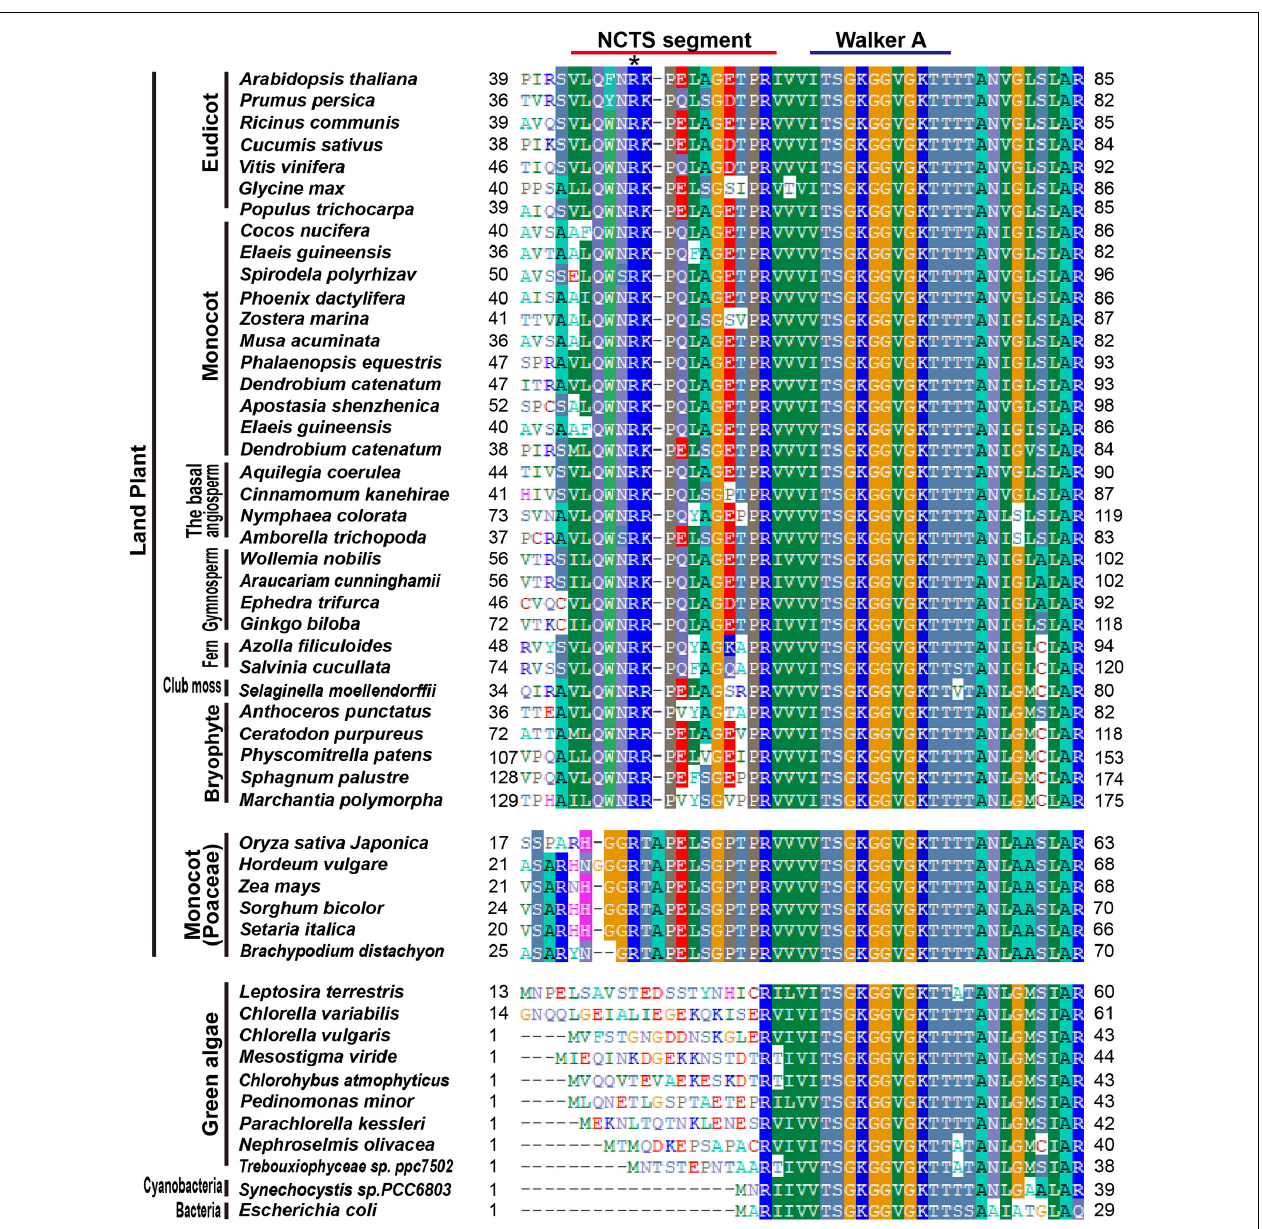
FIGURE 2 | Protein sequence alignment analysis of MinD in different species. An alignment of the extreme N-terminal region of AtMinD1 with the corresponding region of MinD from various organisms is shown. N-terminal Conserved Terrestrial Specific (NCTS) domain (44th–58th) in land plants has been underlined. Asterisk position was the point mutation site of cdm75, which is a mutant of